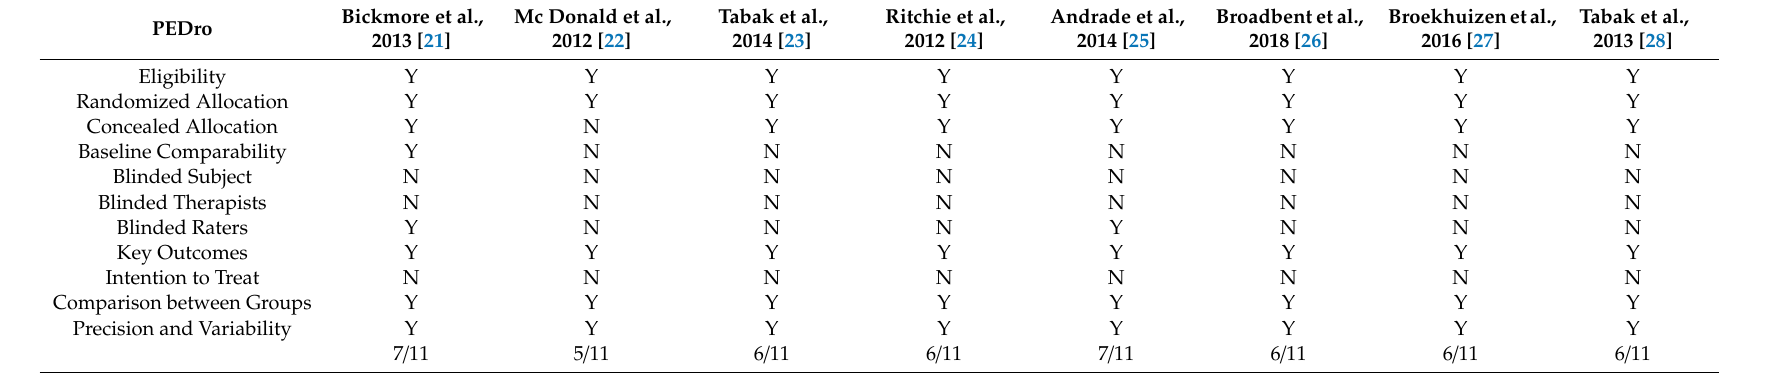
Table 1. Scores of methodological quality assessment of the included